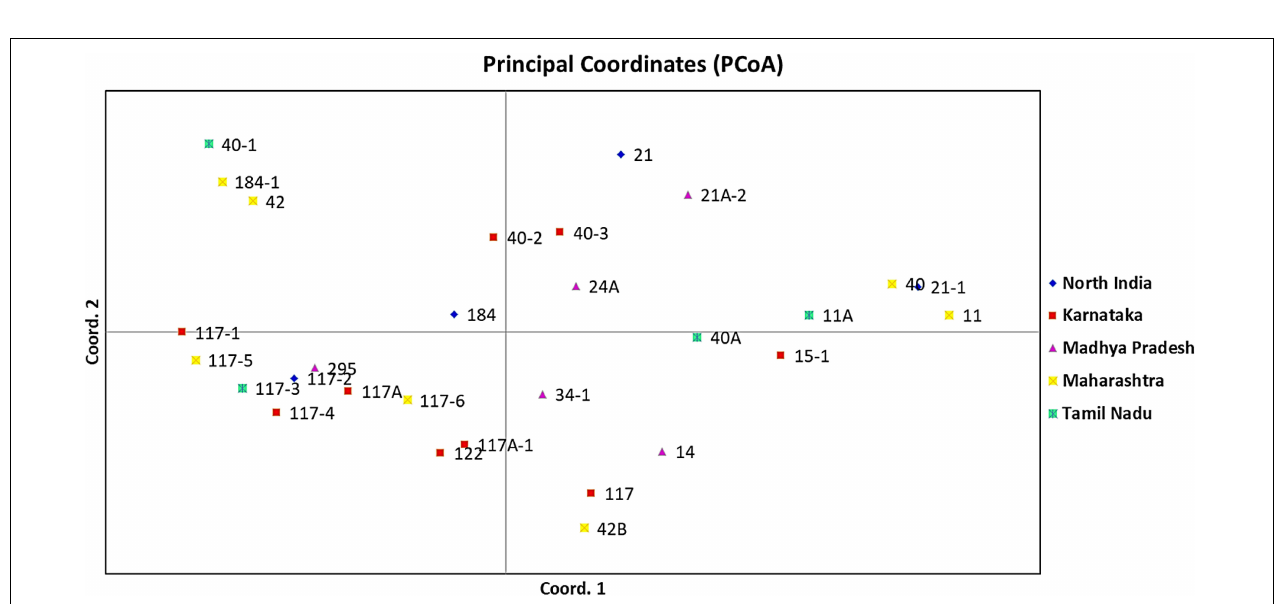
FIGURE 6 | Principal coordinate analysis (PCoA) of P. graminis f. sp. tritici pathotypes from different geographical regions of India using 37 polymorphic SSR markers. The first and second principal axes revealed 13.03% and 12.08% of the total variation, respectively.